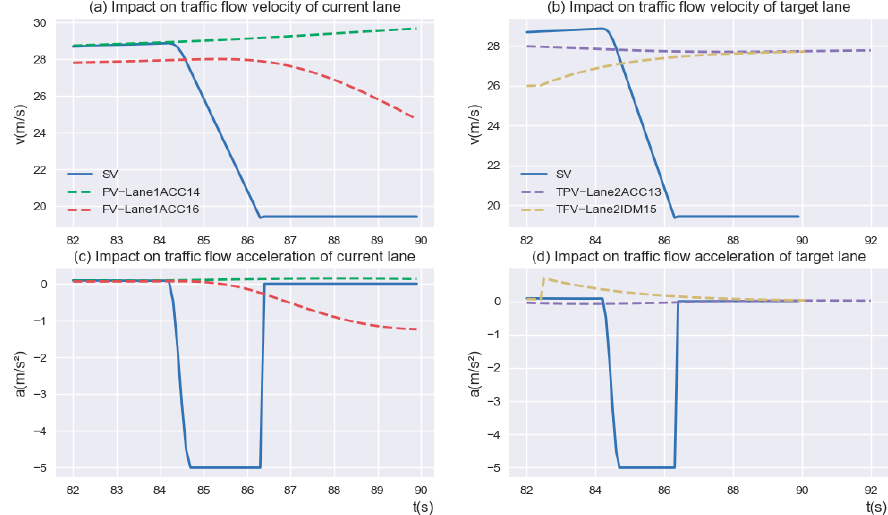
Figure 11. Impact on ahead and behind vehicles of “Aggressive driver” driving. To further investigate the impact of “Aggressive drivers” on the traffic flow behind the current position of SV, the speed acceleration variation of the second to fourth vehicles behind the SV was analyzed, as shown in Figure 12. The motion state of the corresponding vehicles without lane-changing maneuvers was used as a comparison. The results showed that although the rear traffic flow exhibited the characteristics of string stability, compared with the traffic flow operation under the “Proposed strategy”, the rear traffic flow showed great volatility and an overall decrease in driving velocity, which greatly affected the op- erational efficiency of the traffic flow in the diverging area.